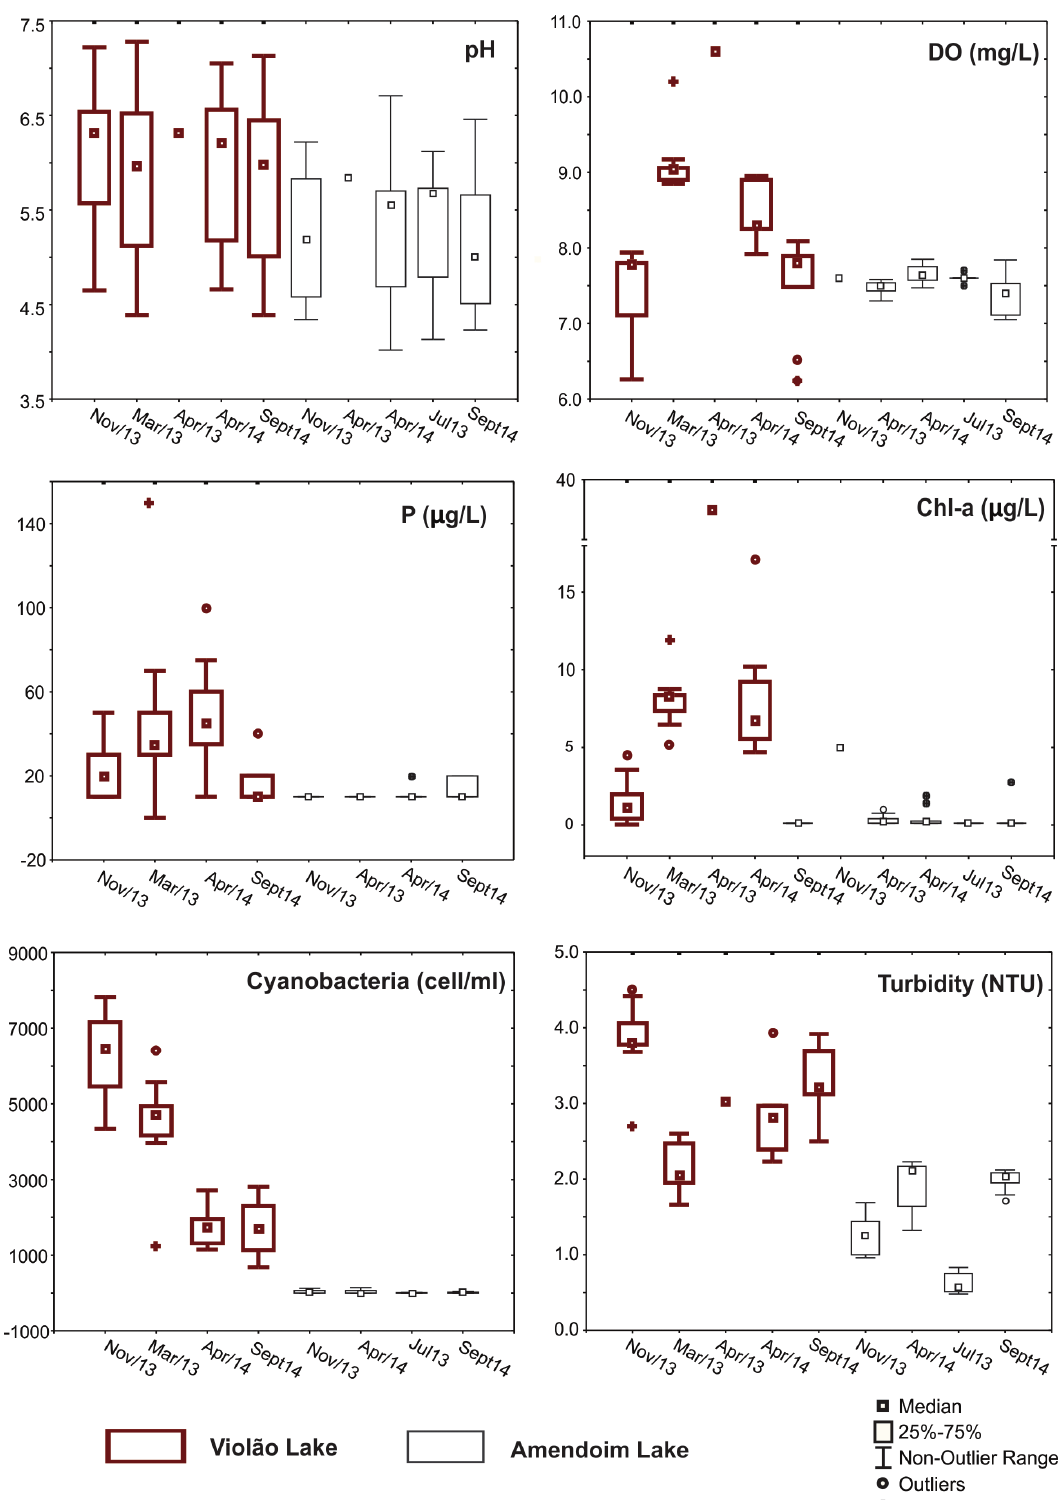
Figure 4 - Box and whisker plot for selected physicochemical and biological parameters in different period of the Violão and Amendoim